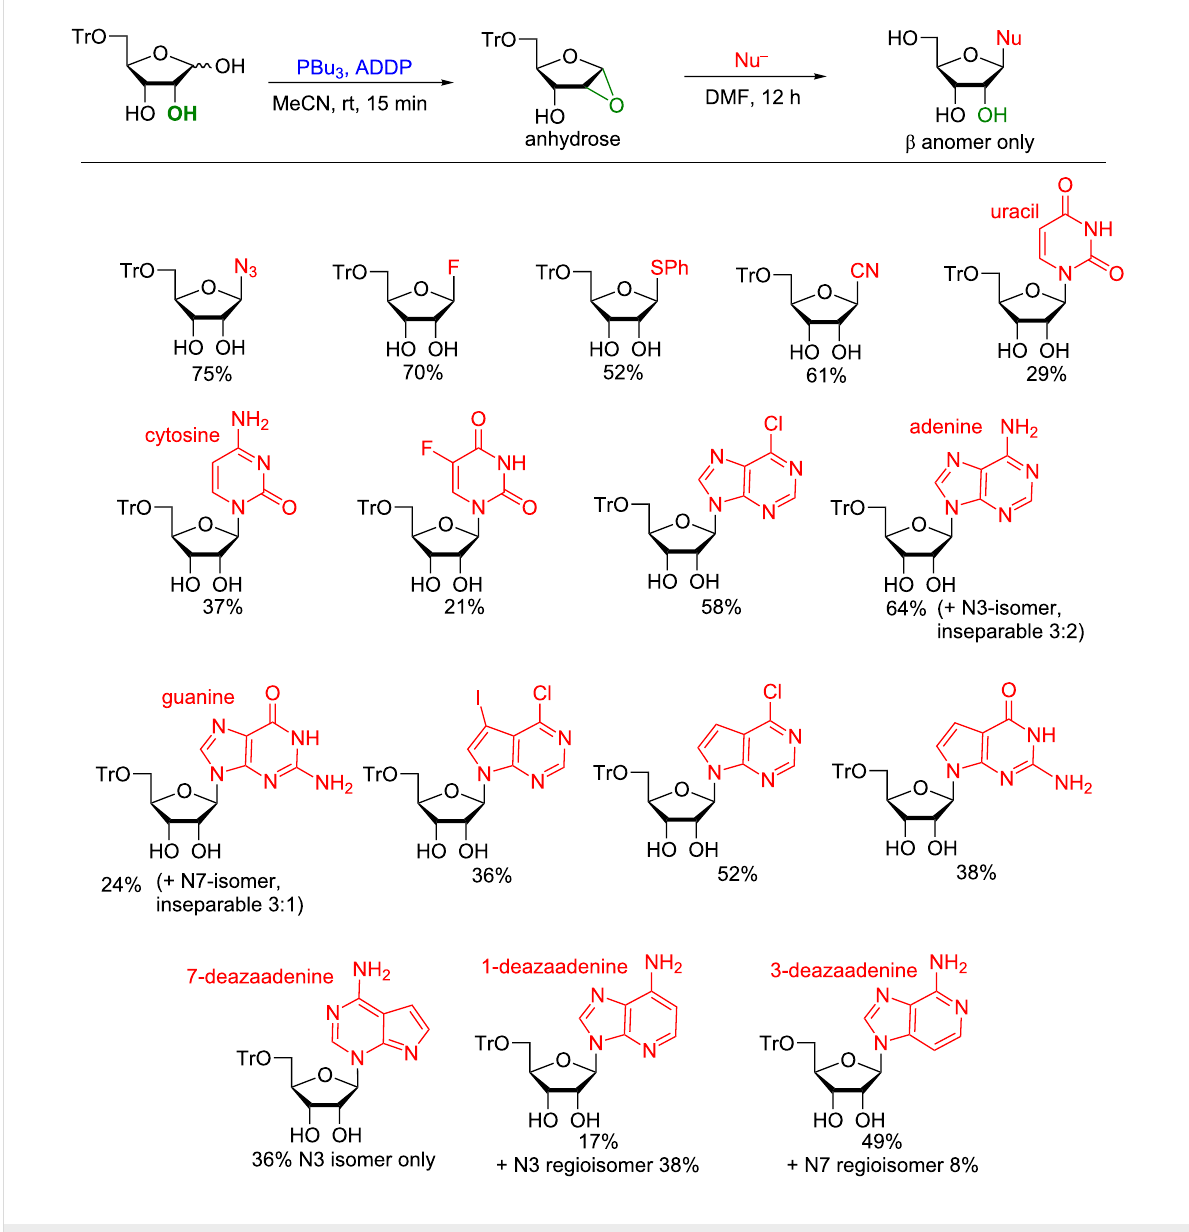
Figure 11: Synthesis of ribofuranosides using a monoprotected ribosyl donor via an anhydrose intermediate.